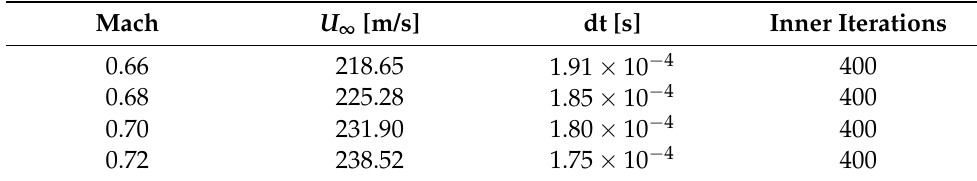
Table 1. Time step size: ∆ x = 4.17%c per time step for each Mach